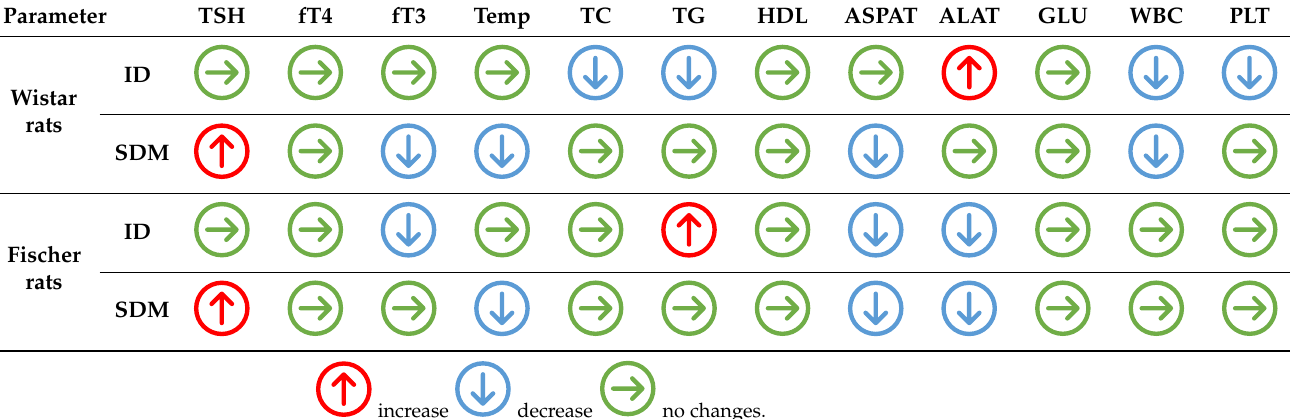
Table 6. Influence of the breed of rats on the selected parameters in two in vivo models of hypothy- roidism, caused by iodine deficiency (ID) or sulfadimethoxine (SDM) diet [4,15,17], see Section 2. for the explanation of the groups’ acronyms and all abbreviations.